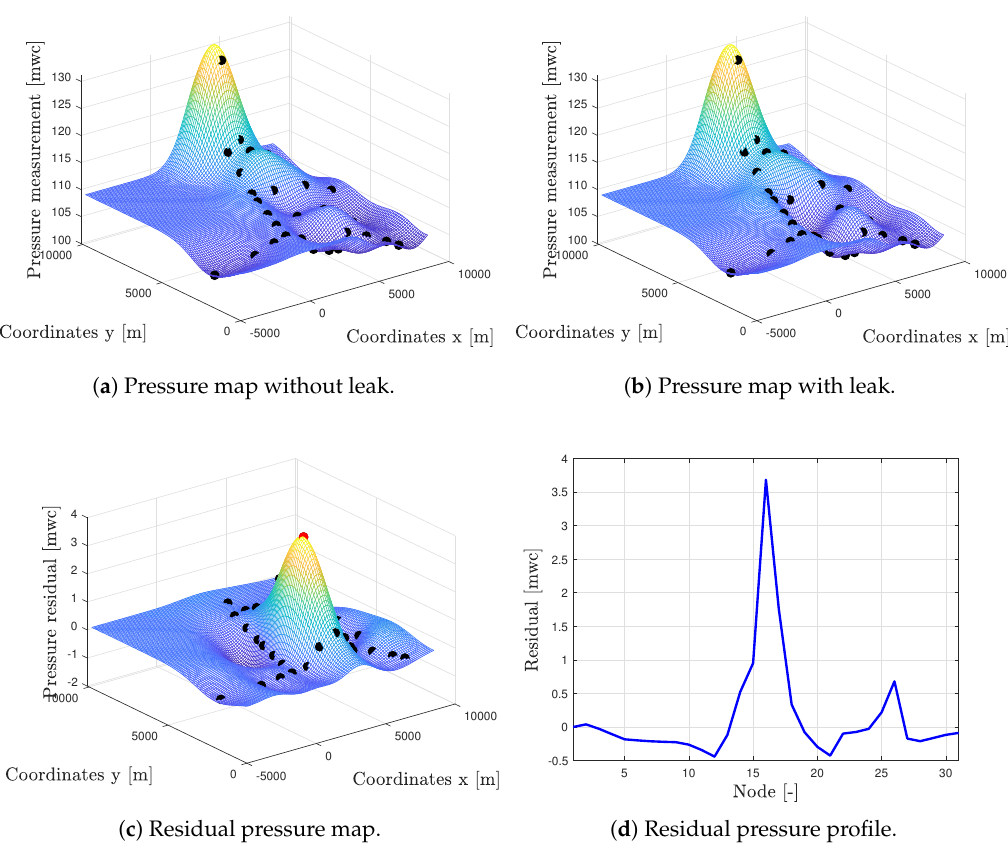
Figure 5. Kriging interpolation for the case of a leak of 100 [ L/s ] at node